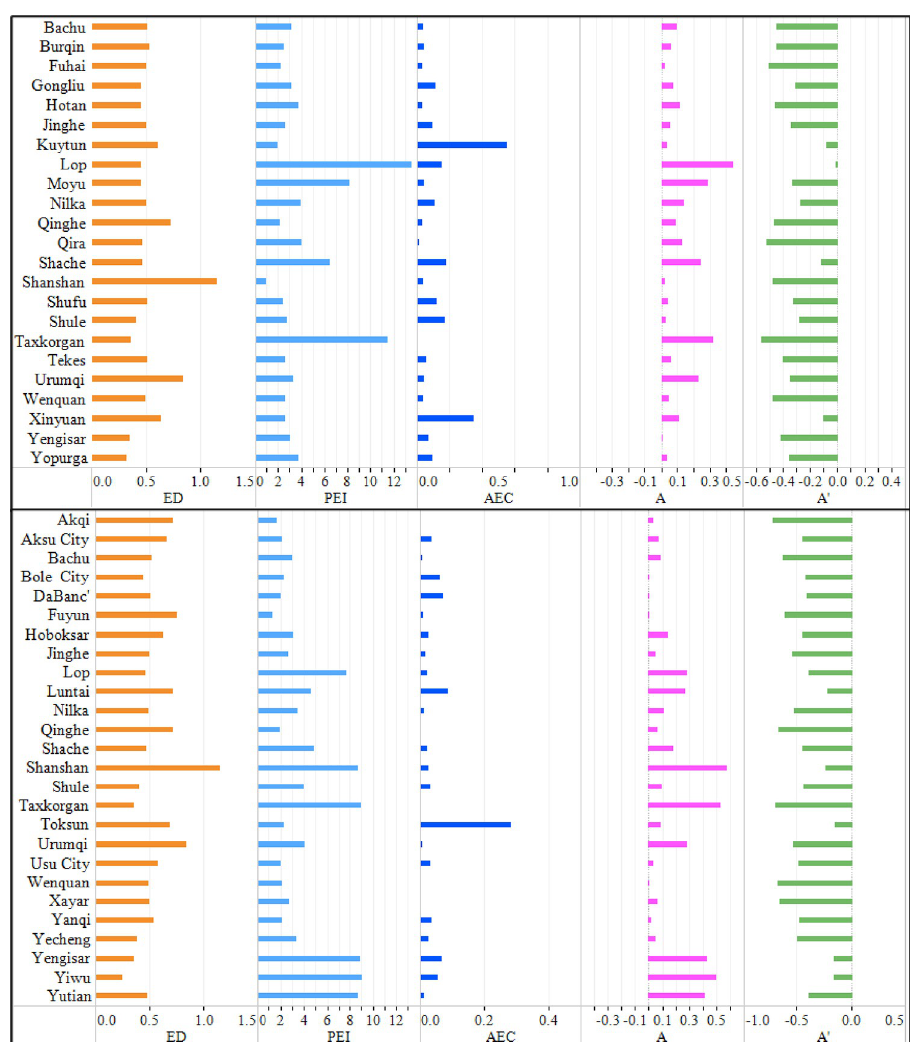
Fig 6. Causes of decomposition of air pollutants in counties and cities with a “poor ! good” change trend.